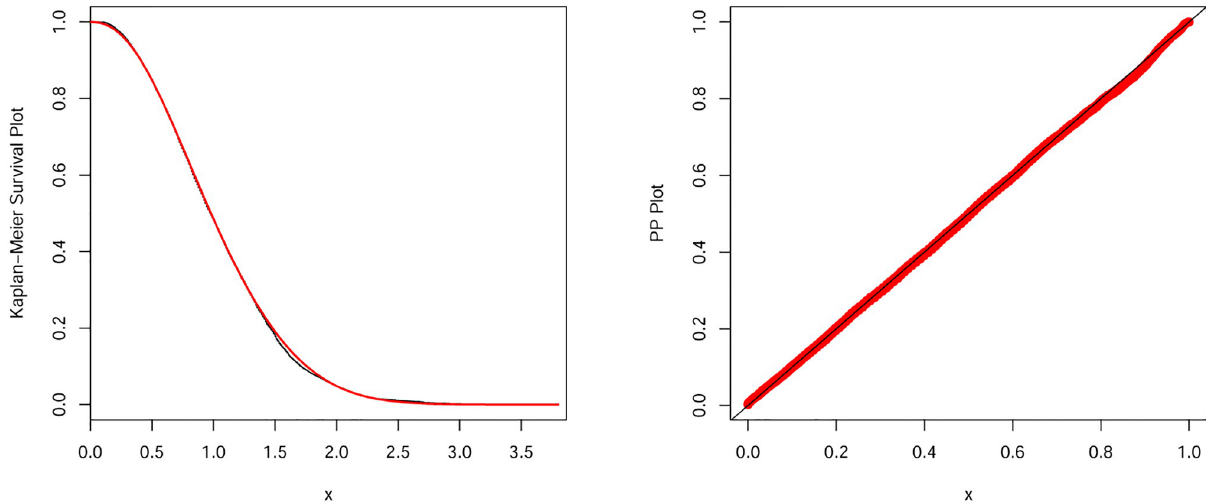
Fig 6. Kaplan Meier survival and PP-plots of the NEHTW distribution for earthquake insurance data set.